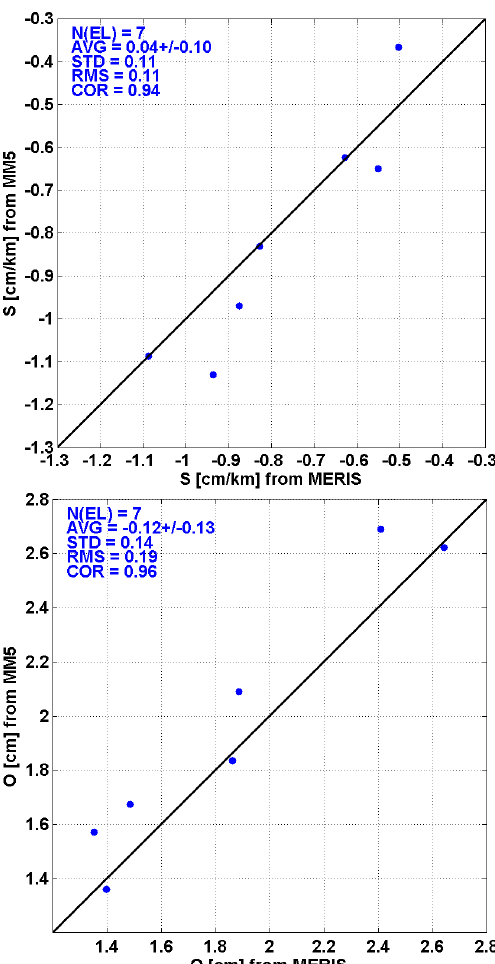
Fig. 8. Scatter plots of slopes S (top) and offsets O (bottom) of IWV vs. height trends extracted from MM5 and MERIS data from the 7 match-up cases during the